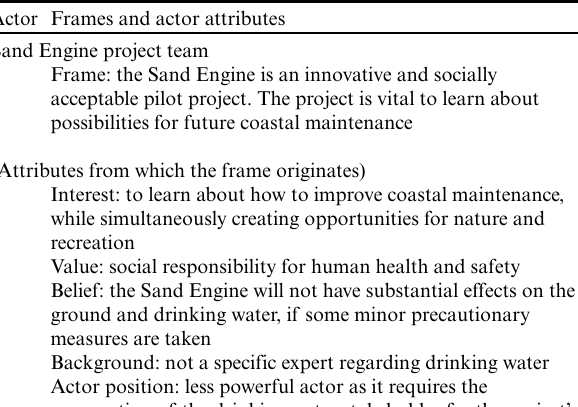
Table 3 . Sand Engine ambiguity 2: about the effects on beach recreation conditions.